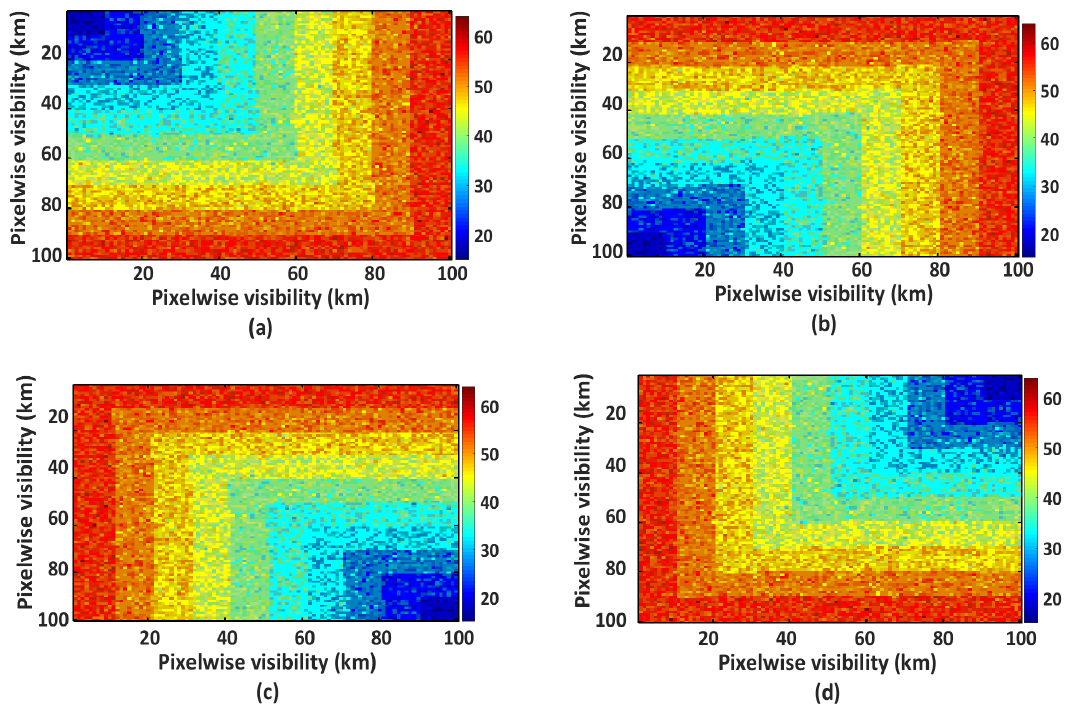
Figure 14. Pixelwise perturbation to the spatial variability of visibility with diagonal variation ( a ) top left to bottom right; ( b ) bottom left to top right; ( c ) bottom right to top left; ( d ) top right to bottom